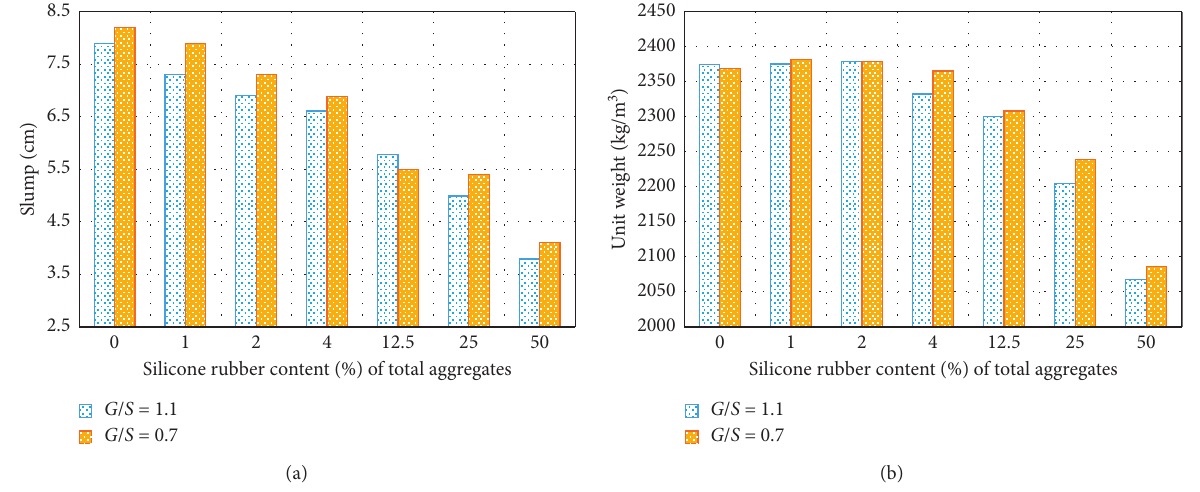
Figure 3: Properties of fresh HSRC. (a) Slump. (b) Unit weight of fresh HSRC. Table 5: Changes in strengths with respect to control strength (LF specimens and HF specimens) and percentage of retained strength with respect to control